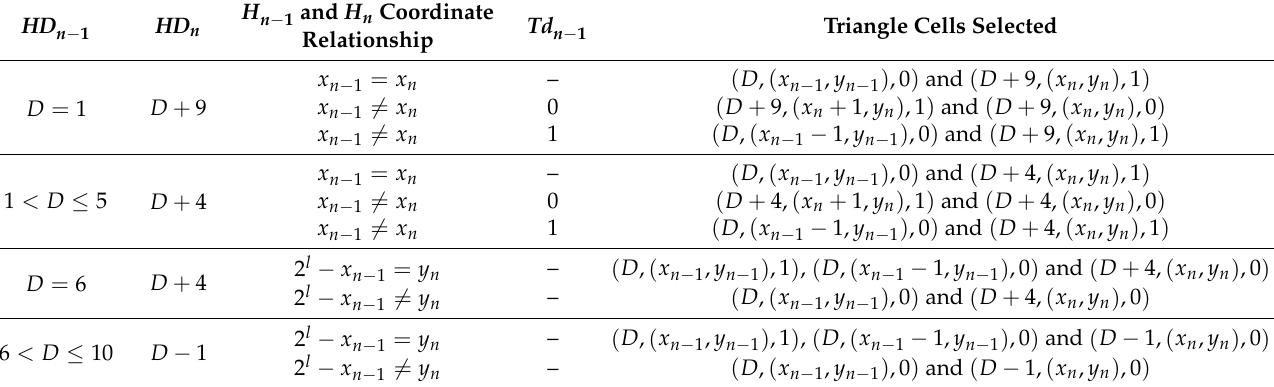
Table 4. Htotcode rule of the ( n − 1)th hexagon cell B 1 .